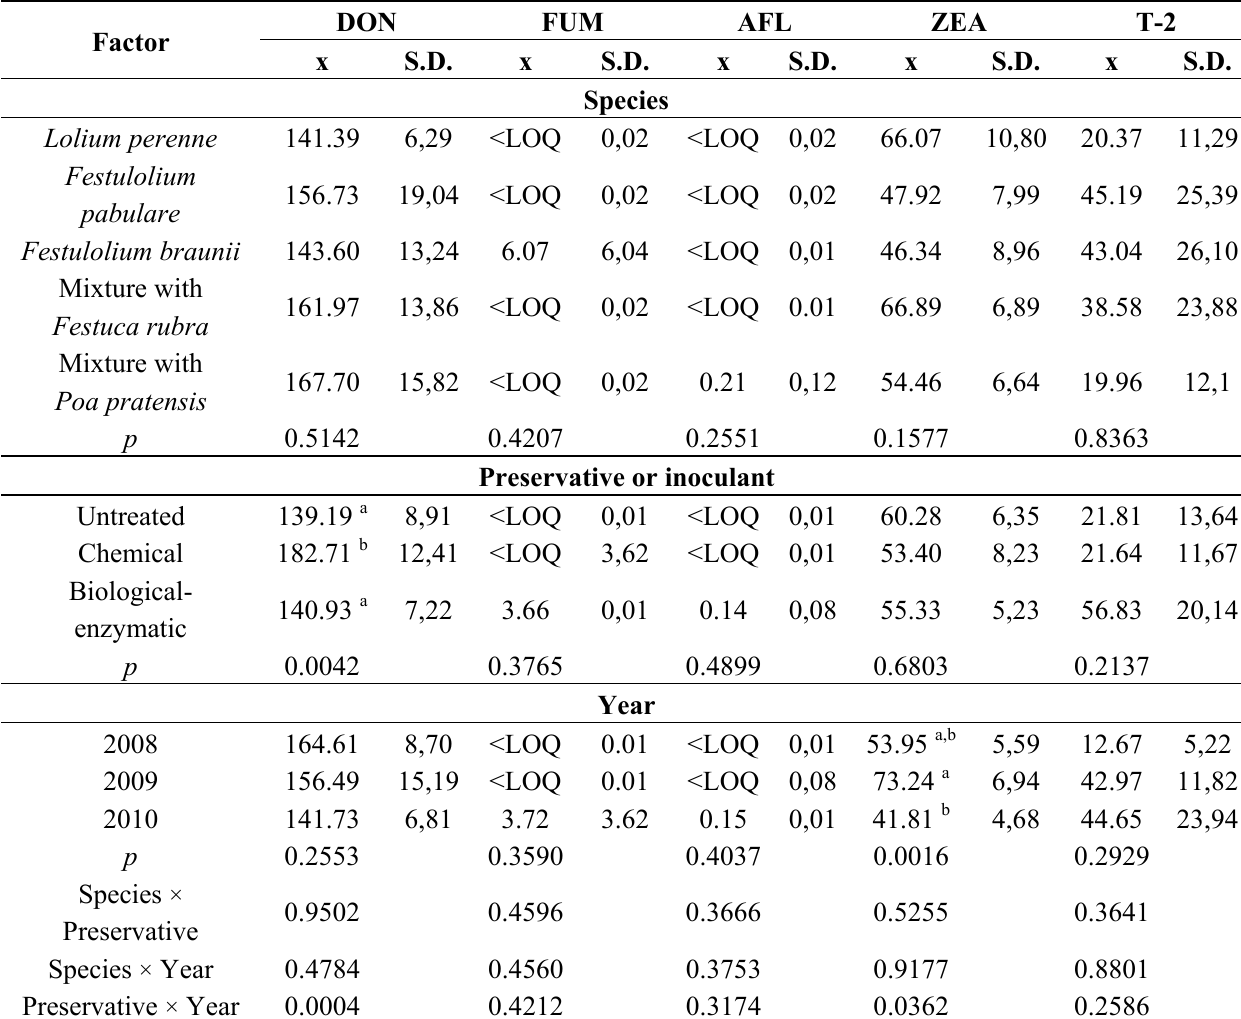
Table 2. Influence of species, preservative or inoculant, and year on the content (ppb) of deoxynivalenol (DON), fumonisin (FUM), aflatoxin (AFL), zearalenone (ZEA) and T-2 toxin (T-2) in silages from the first cutting of